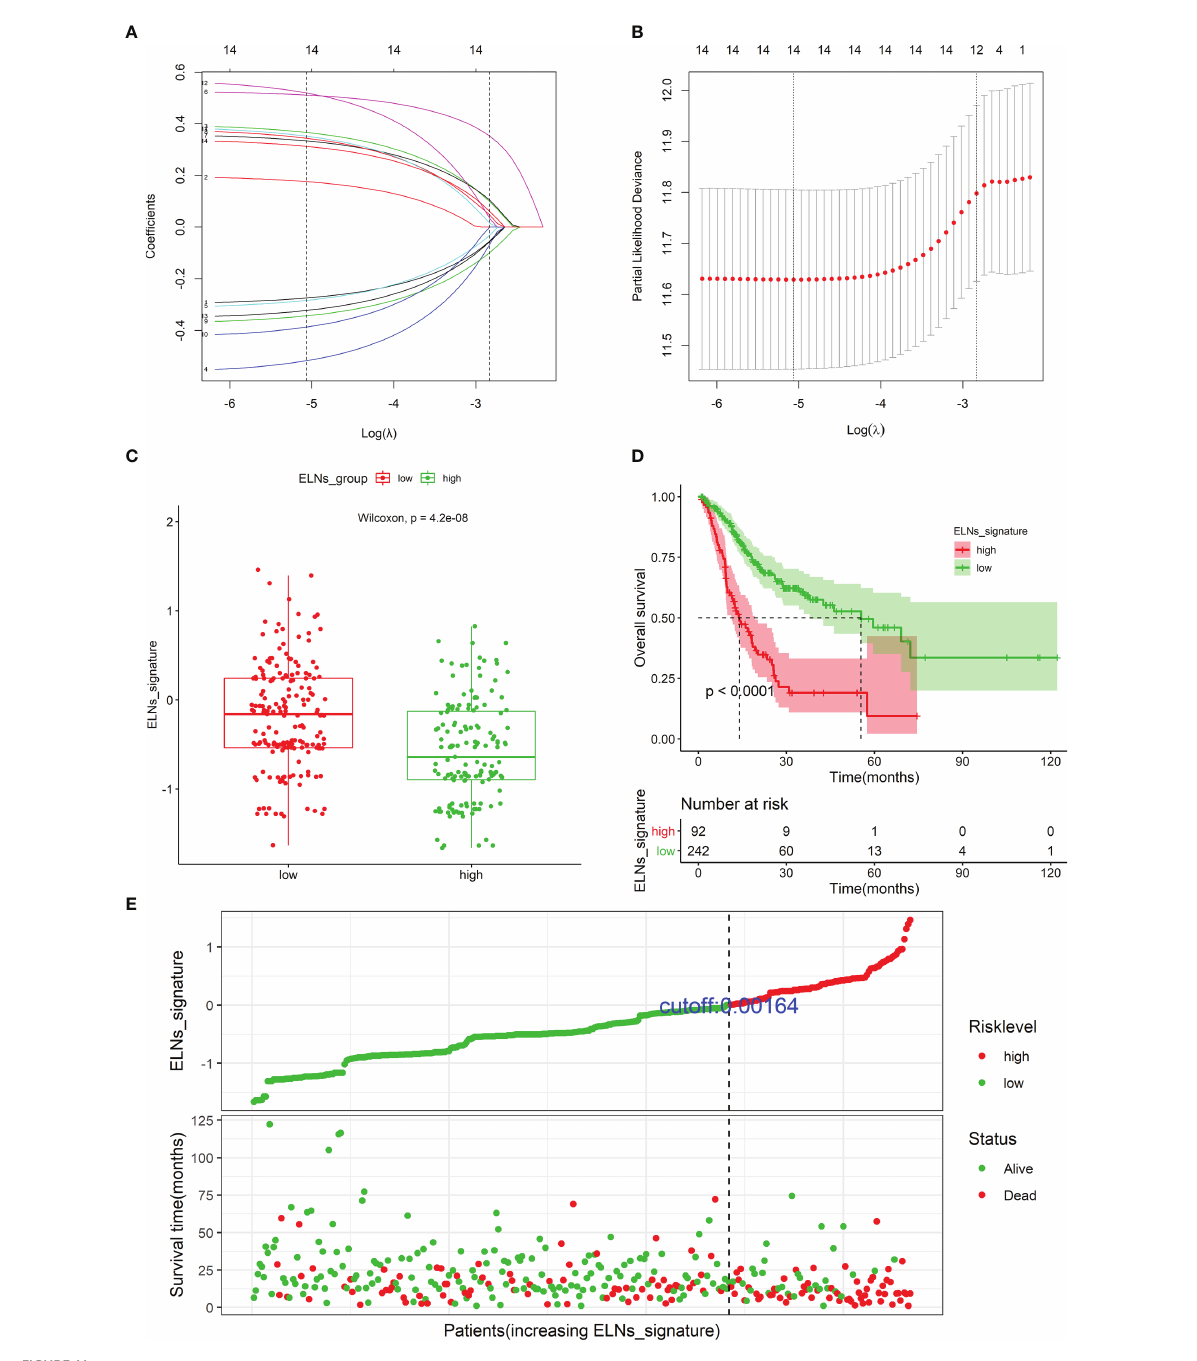
FIGURE 11 Identifying prognostic genes and cells for developing an ELNs signature. (A) LASSO coef fi cient pro fi les of the 14 survival-related factors in the TCGA cohort. (B) Selection of the optimal parameter (lambda.1se = 0.05892685) in the LASSO regression model. (C) The distribution of the ELNs signature between the high- and low-ELN groups using Mann – Whitney U-test. (D) Kaplan – Meier survival curve of patients with high- and low-ELN signature groups. (E) Distribution of the ELNs signature in the TCGA cohort. ELNs, the number of lymph nodes